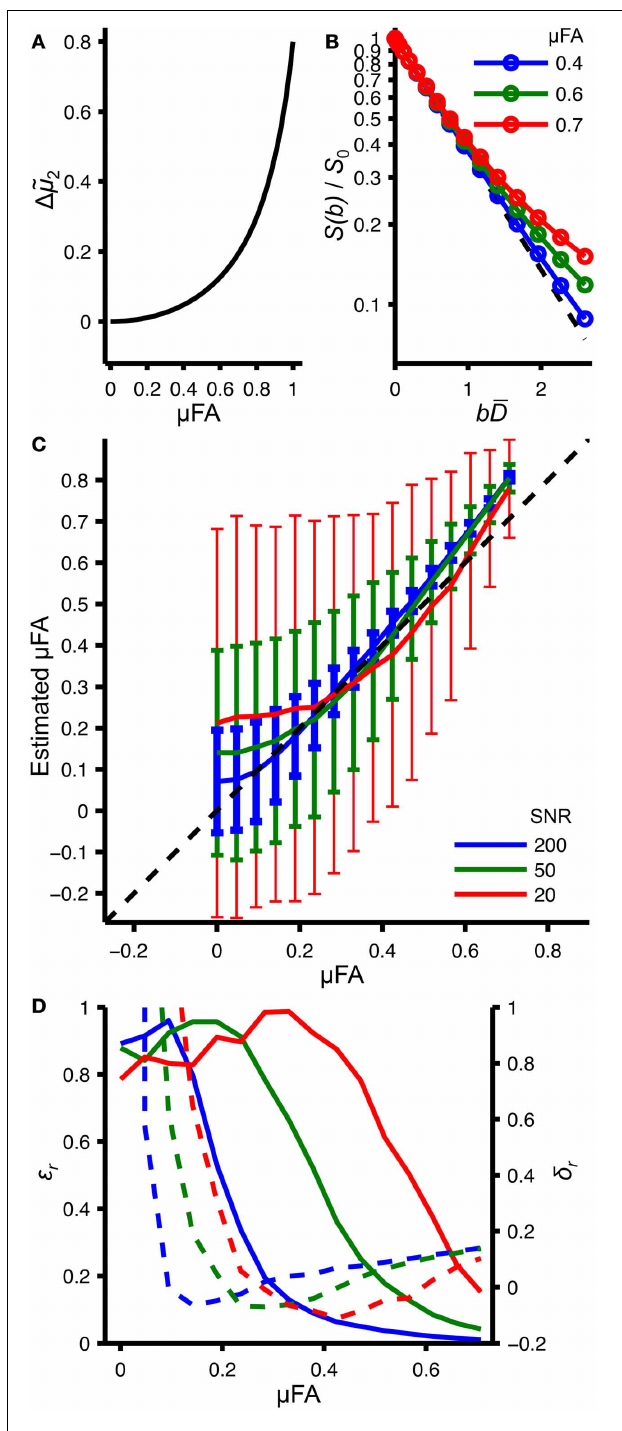
FIGURE 2 | Random and systematic errors in estimating the microscopic fractional anisotropy. (A) Relation between microscopic fractional anisotropy ( μ FA) and the difference in variance, (cid:20)(cid:21) (cid:19) μ 2 − μ iso (cid:3) (cid:17) μ 2 = D 2 , calculated with Equation (14). 2 (B) Powder-averaged signal attenuation, S ( b )/ S 0 , for an axially symmetric anisotropic system corresponding to different μ FA values (solid lines with circles), calculated based on Equation 35 in [34] using the relations in